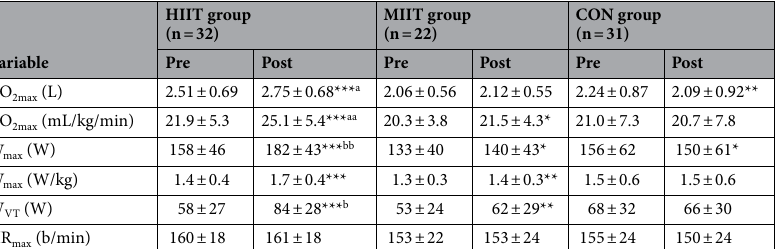
Table 3. Daily nutritional intake pre-intervention and during the last week of the intervention. Values are expressed as mean ± SD. HIIT high-intensity interval training group, MIIT moderate-intensity interval training group, CON control group, CHO carbohydrates. *( p < 0.05), significantly different from pre-intervention.